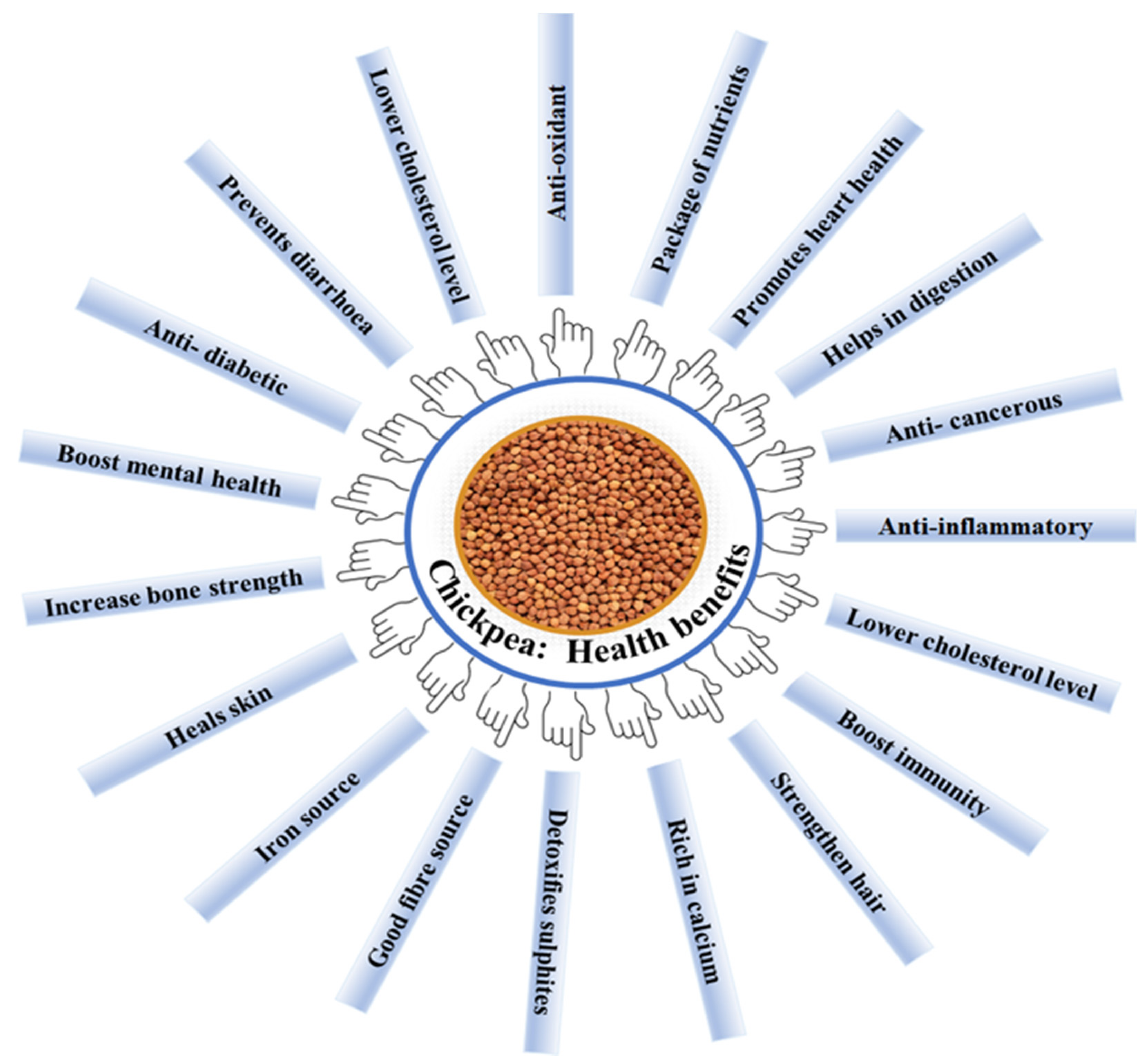
Figure 2. Commercialized chickpea- based snacks of different countries. Malic, oxalic acids are found in the glandular secretions of chickpea leaves, stems, and pods and also have some traditional therapeutic characteristics. These sour-tasting acid exudates might be used as vinegar or as medicine and these acids were traditionally harvested in India at night by draping a thin muslin cloth over the crop. The liquid was collected in bottles after the saturated towel was wrung out in the morning and this exudation from the plant’s leaves can damage clothes. These exudates can treat several diseases such as dyspepsia, cholera, sunstroke, Bronchitis, constipation, diarrhea, flatulence, snakebite, catarrh, and warts and can also reduce blood cholesterol levels. In one study on rats, they were also found to be essential in controlling blood cholesterol levels.